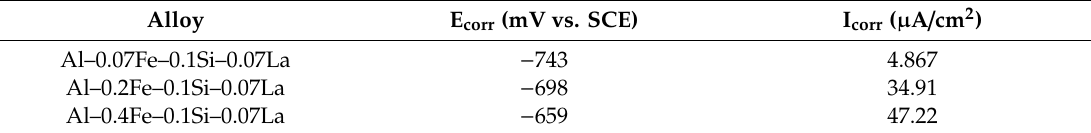
Figure 4. Typical Tafel polarization curve of the Al–xFe–0.1Si–0.07La alloys tested in a 3.5% NaCl solution. Table 3. Tafel polarization parameters of the Al–xFe–0.1Si–0.07La alloys tested in a 3.5% NaCl